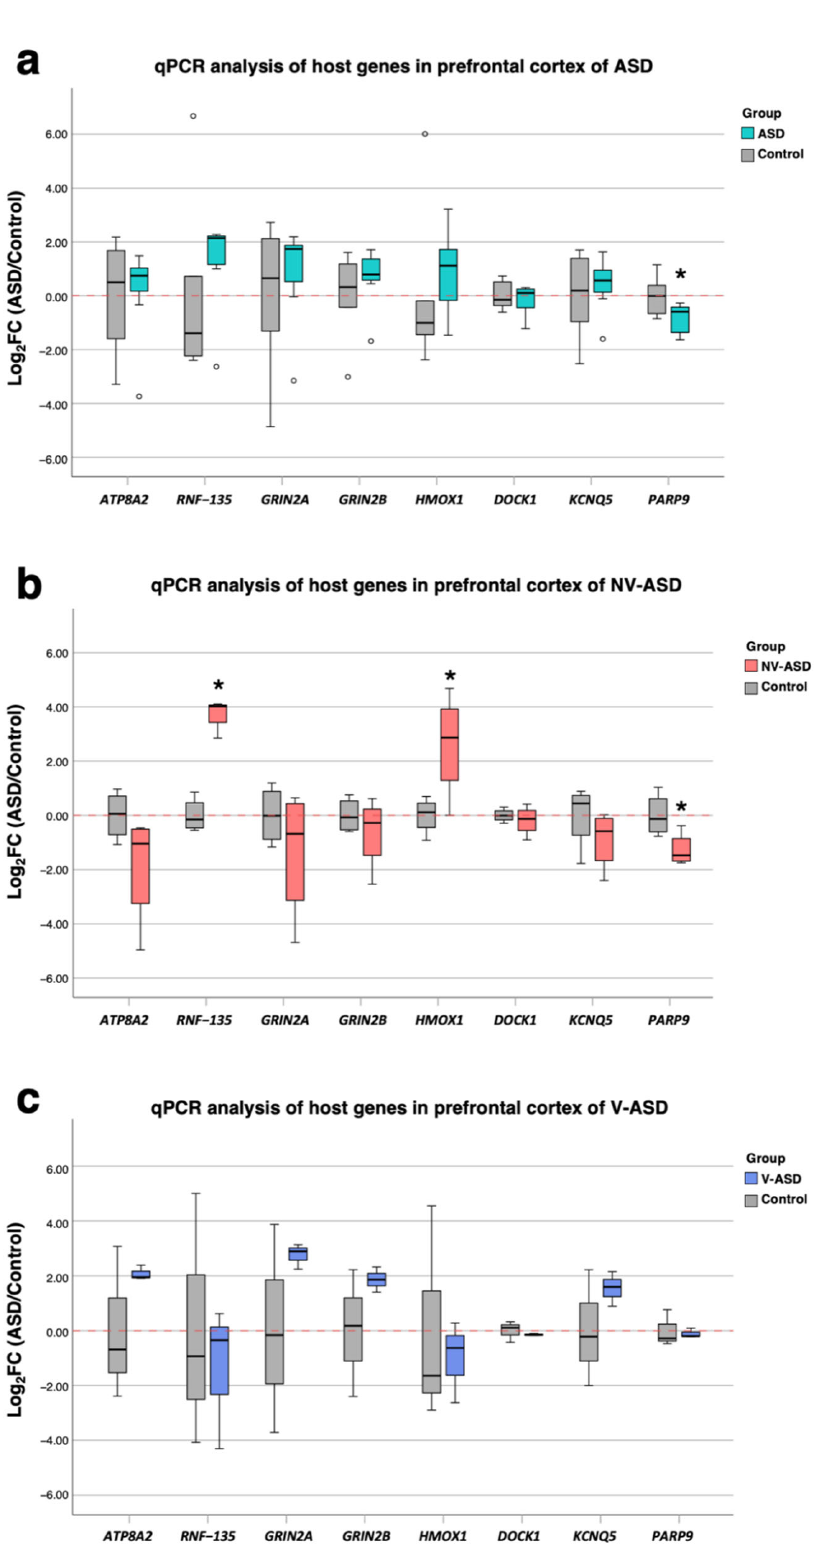
Figure 8. Quantitative RT–PCR analysis of selected DEGs significantly correlating with DE-Alu elements: ( a ) Box plot of the comparison between ASD ( n = 7) versus unaffected ( n = 6) individuals. ( b , c ) Box plot of the comparison between ASD subtype (NV-ASD and V-ASD) versus sex- and age-matched unaffected individuals. Dots represent outliers and * p < 0.05.